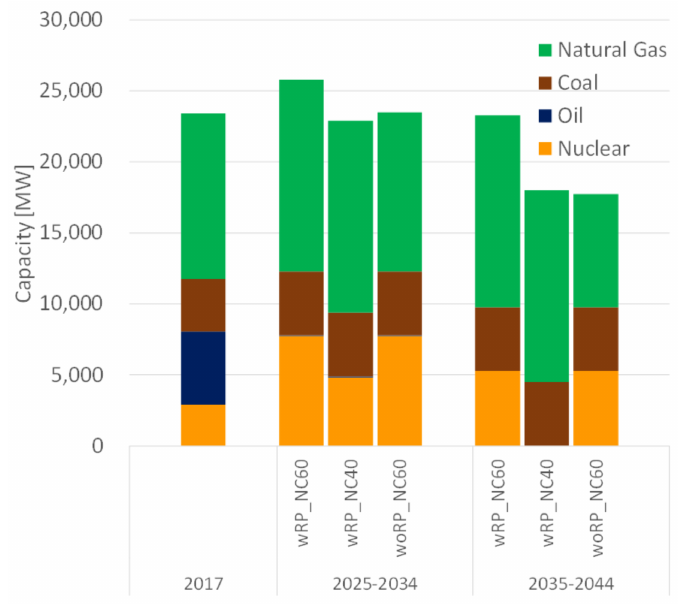
Figure 6. National power grid in the Kansai region of Japan.